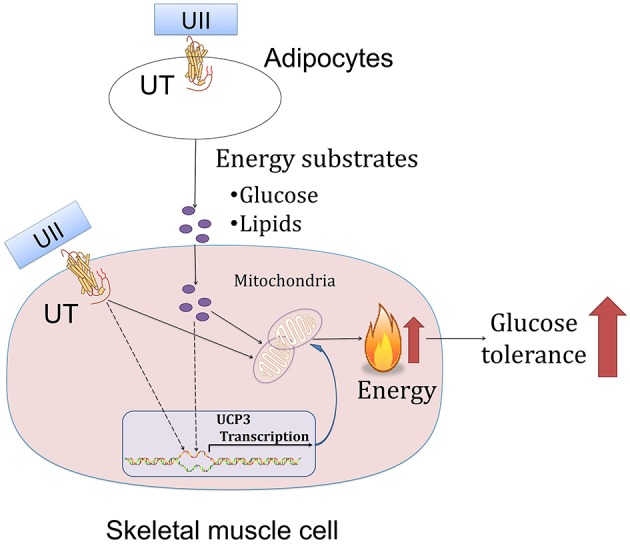
A schematic diagram illustrating the proposed mechanism of urotensin-II.